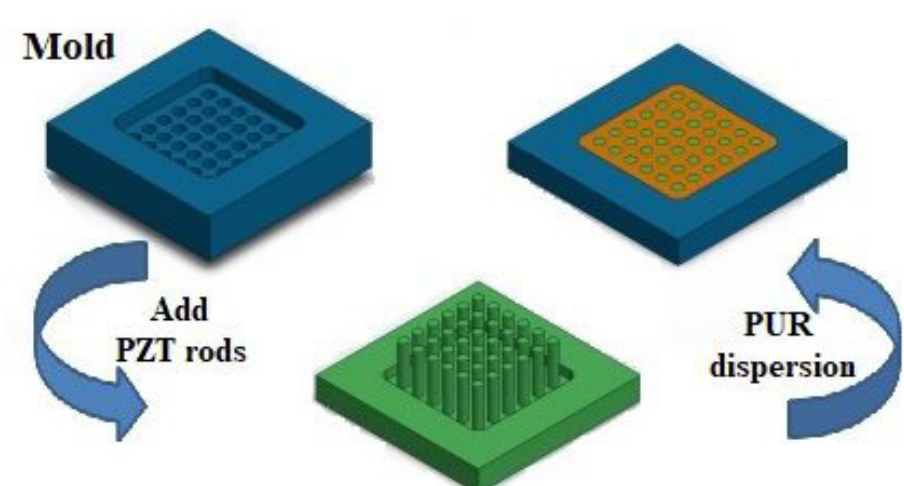
Figure 1. Representation of the teflon mold for obtaining piezoelectric composites with 1-3